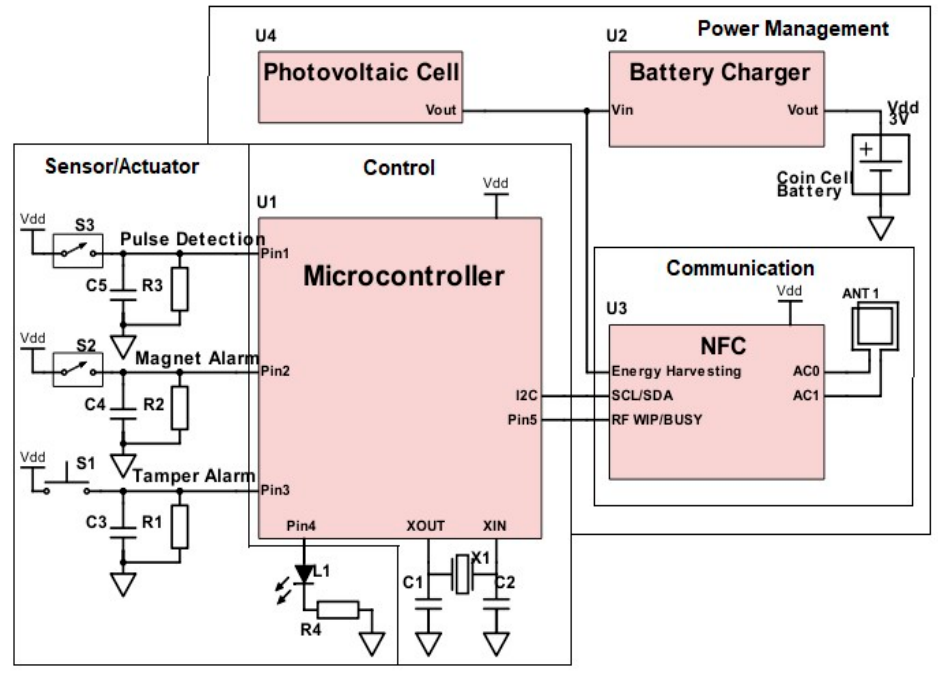
Figure 1. Block diagram of the add-on electronic device. It consists of four main modules: power management, sensor/actuator, control and